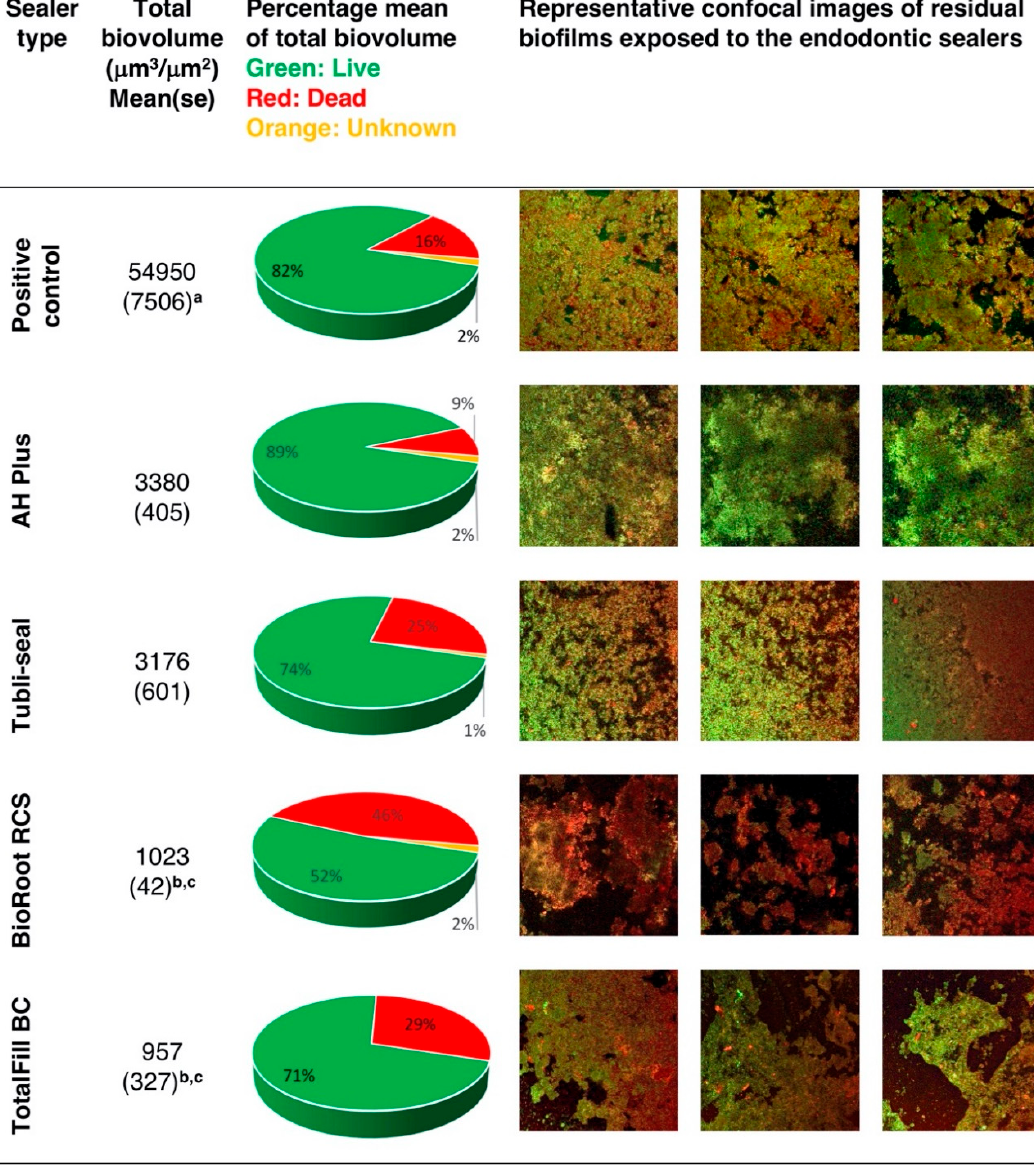
Figure 3. The effects of endodontic sealers on biofilm inhibition. The results represent the remaining mean ( ± standard error) values of total biovolume ( µ m 3 / µ m 2 ) and their respective mean percentages of dead (red), live (green) and unknown (orange) microbial populations. Representative confocal images of residual biofilms are also presented. a Mean (se) total biovolume values significantly higher compared to all experimental groups ( p < 0.05) b Mean (se) total biovolume values of TotalFill BC and BioRoot RCS significantly less compared to AH Plus ( p < 0.05) c Mean (se) total biovolume values of TotalFill BC and BioRoot RCS significantly less compared to Tubli-seal ( p < 0.05).